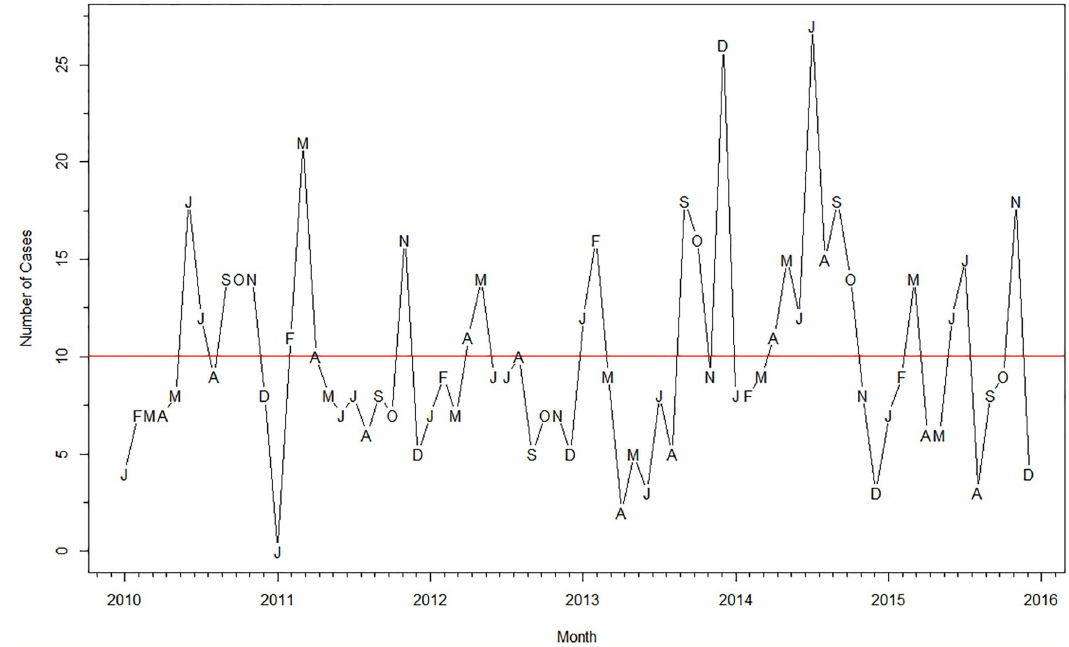
Fig 1. Time series of pediatric TB cases, Kampala, Uganda, 2010-2015. Months indicated by letters, red line represents the mean number of cases per month (10) over the five-year period.